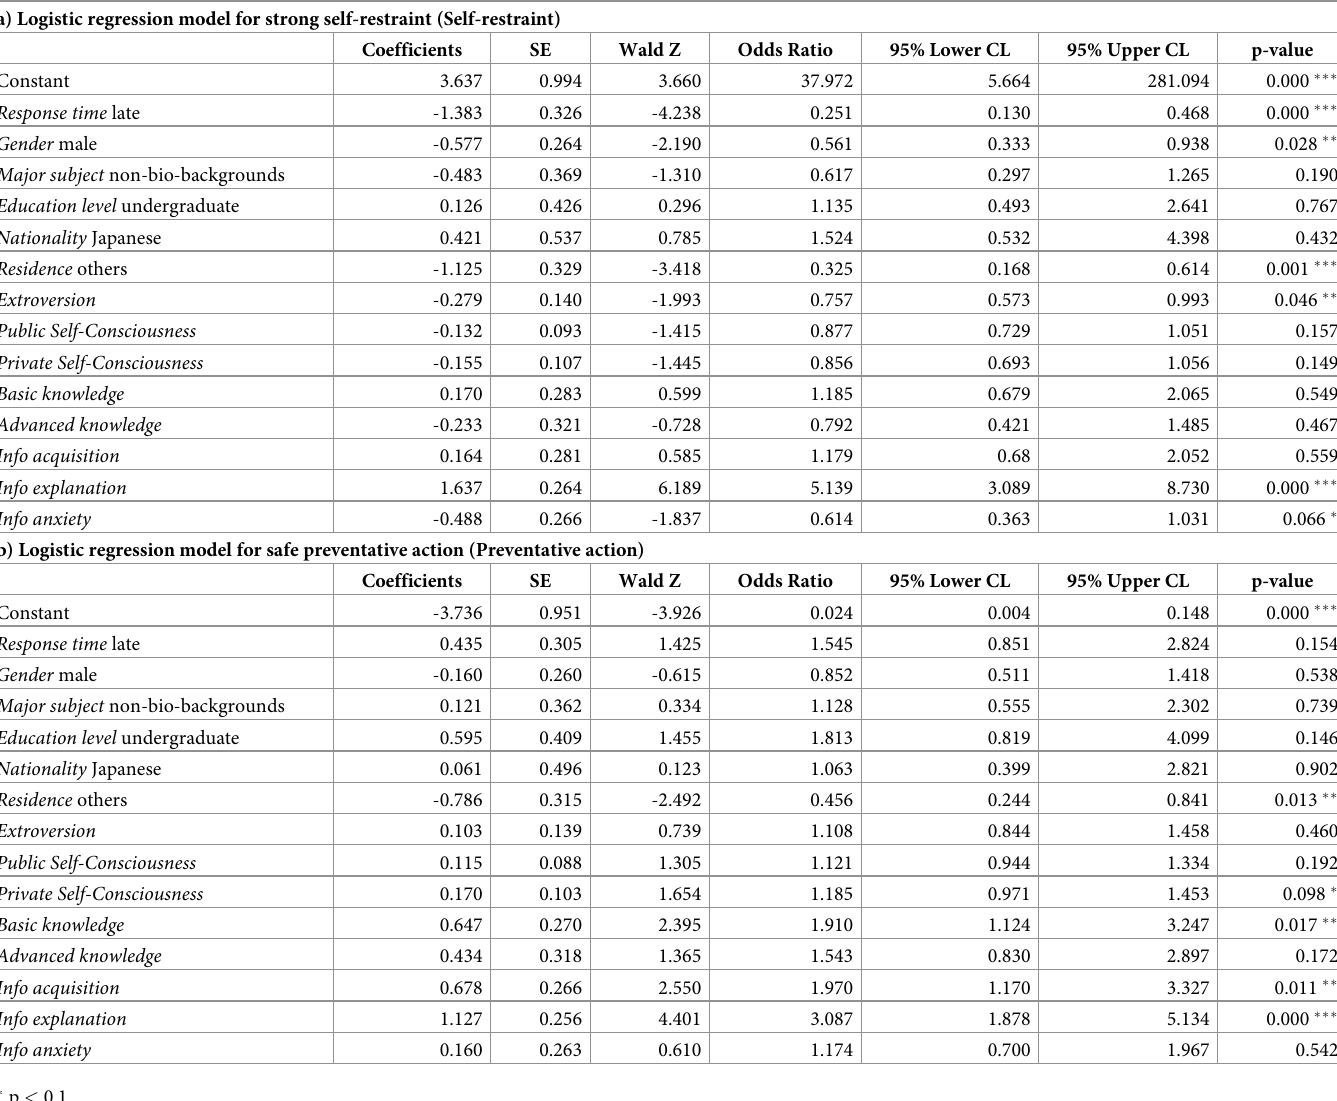
Table 4. Logistic regression models for university students’ preventative practices and behaviors. a) Logistic regression model for strong self-restraint